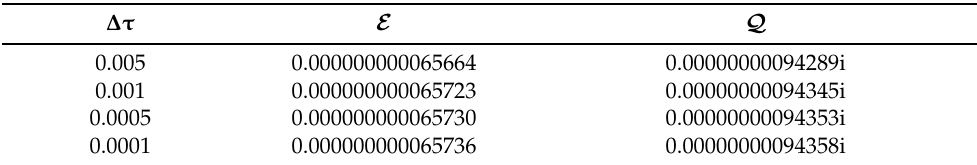
Table 3. Conservation laws at various time steps with M = 8 and T = 1 for Test Problem